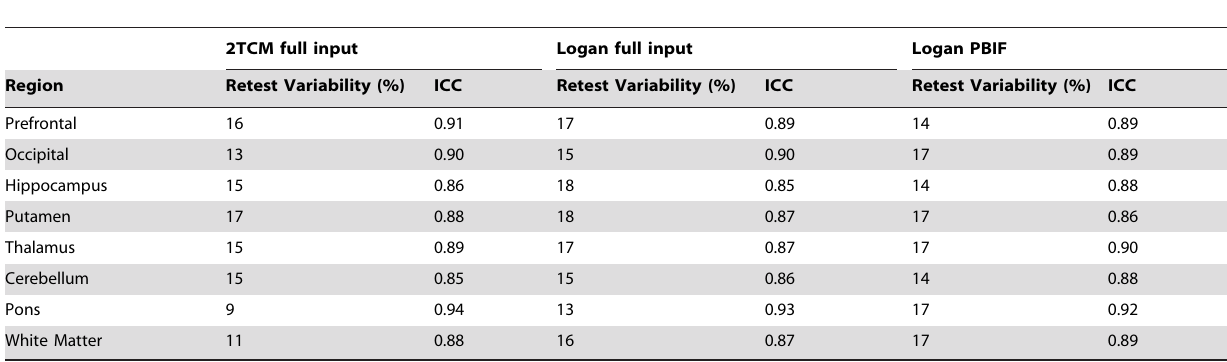
Table 1. Retest variability for 2TCM, Logan with full input, and Logan with PBIF, respectively.